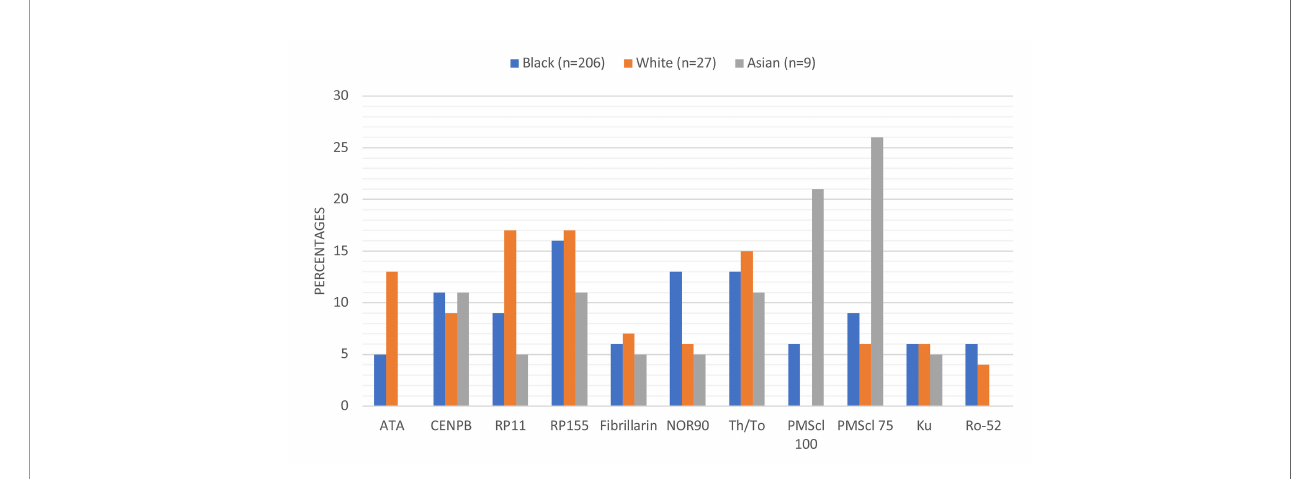
FIGURE 2 | Proportions and types of autoantibodies detected in different racial groups. Anti-ATA and anti-Ro-52 were not detected in any of the Asian patients and anti-PMScl-100 was not detected in any White